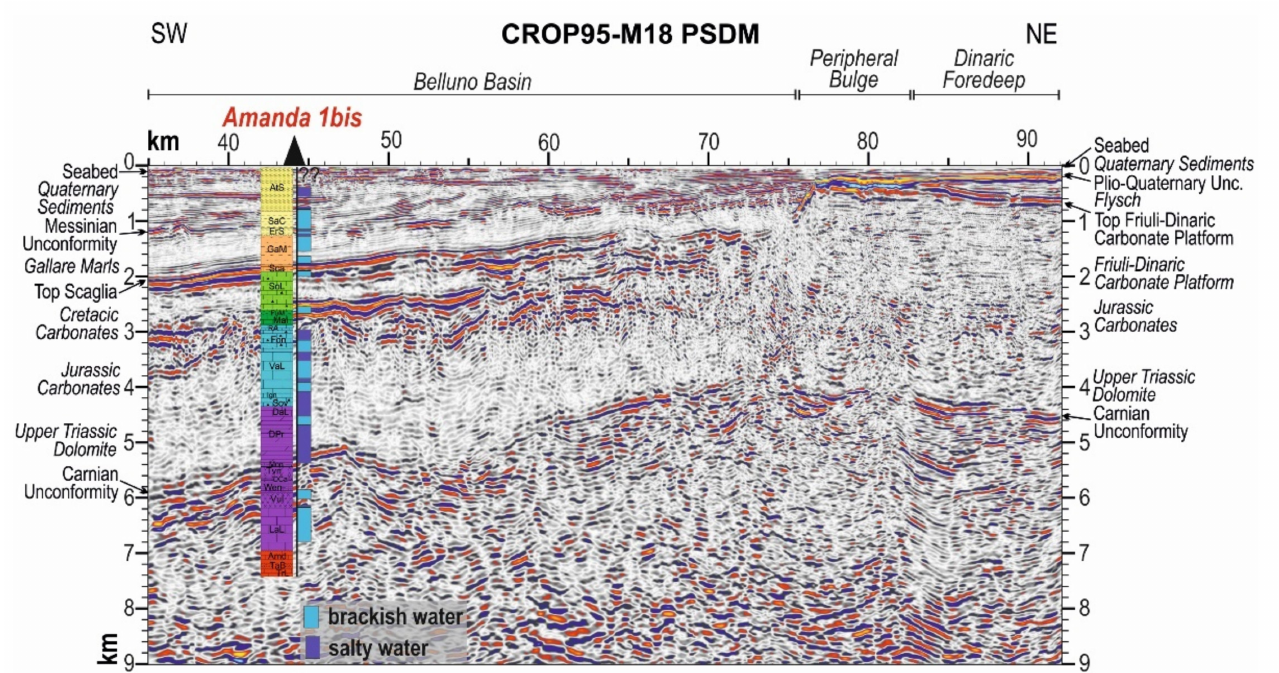
Figure 3. Pre-stack depth migrated [71] seismic profile CROP95-M18. The Amanda 1bis exploration well [63], drilled up to 7280 m, is located about 2 km south-westward. Its stratigraphy calibrates the seismic: the thick carbonate sequence is composed of Meso-Cenozoic carbonates, whose top deepens SW-ward up to 3 km depth in the Belluno Basin. Here, they are covered by the Eocene-Miocene Gallare Marls. In correspondence of the peripheral bulge, in front of the Grado Island, the carbonates of the Friuli-Dinaric Carbonate Platform raise up to 600 m and deepen NE-ward in the Dinaric foredeep domain filled by the Eocene Flysch. The top of the Eocene-Miocene terrigenous units is depicted by Messinian Unconformity due to sea level drop. This unconformity is in turn buried under Pliocene progradation eroded at the top by Mid-Pliocene Unconformity, in the Belluno Basin; whereas in the eastern part of the area erosion lasted until Mid-Pleistocene. The Plio-Quaternary marine and continental deposits drape the shallowest part of the sedimentary sequence. The well lithostratigraphic units are: Asti Sands (AtS, Quaternary), Santerno Clays (SaC, Lower Pliocene), Eraclea Sands (ErS, Lower Pliocene), Gallare Marls (GaM, Eocene), Scaglia Alpina (Sca, Paleocene), Soccher Limestone (SoL, Upper Cretaceous), Marne a Fucoidi Formation (FuM, Lower Cretaceous), Maiolica (Mai, Lower Cretaceous), Rosso Ammonitico superiore (RA, Upper Jurassic), Fonzaso Formation (Fon, Upper Jurassic), Vajont Limestone (VaL, Middle Jurassic), Igne Formation (Ign, Lower Jurassic), Soverzene Formation (Sov, Lower Jurassic), Dachstein Limestone (DaL, Upper Triassic), Dolomia Principale (DPr, Upper Triassic), Monticello Formation (Mon, Upper Triassic), Trevenanzes Formation (Tvn, Upper Triassic), Dolomia Cassiana (DCa, Upper Triassic), Wengen Formation (Wen, Middle Triassic), Vulcanite (Vul, Middle Triassic), Latemar Limestone (LaL, Middle Triassic), Amanda Formation (Amd, Permian), Tarvisio Breccia (TaB, Permian), Trogkofel Limestone (TrL,